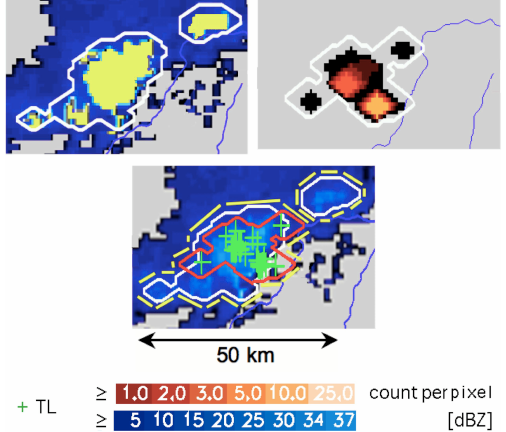
Fig. 1. Illustration of the ec-TRAM cell identification. Upper left: radar cells (white contours) identified by rad-TRAM based on a two-dimensional radar reflectivity field (blue shaded with reflec- tivity values above the detection threshold coloured yellow). Upper right: lightning cells (white contour) identified by li-TRAM based on a two-dimensional lightning frequency map (red shaded). Lower panel: overlay of radar cells and lightning cells with the cell out- lines, identified by ec-TRAM, drawn yellow in dashed line style. The lower ec-TRAM cell consists of a radar cell (white contour) and a lightning cell (red contour). The upper ec-TRAM cell con- sists of a radar cell only. TL events are marked by green